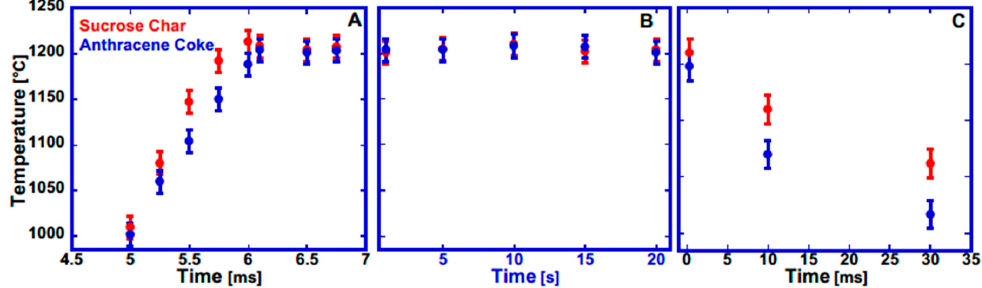
Figure 4. ( A ) Heating rates; ( B ) temperature stability during laser pulse ( C ) and cooling rates for anthracene coke and sucrose char heated with expanded beam CO 2 laser radiation.